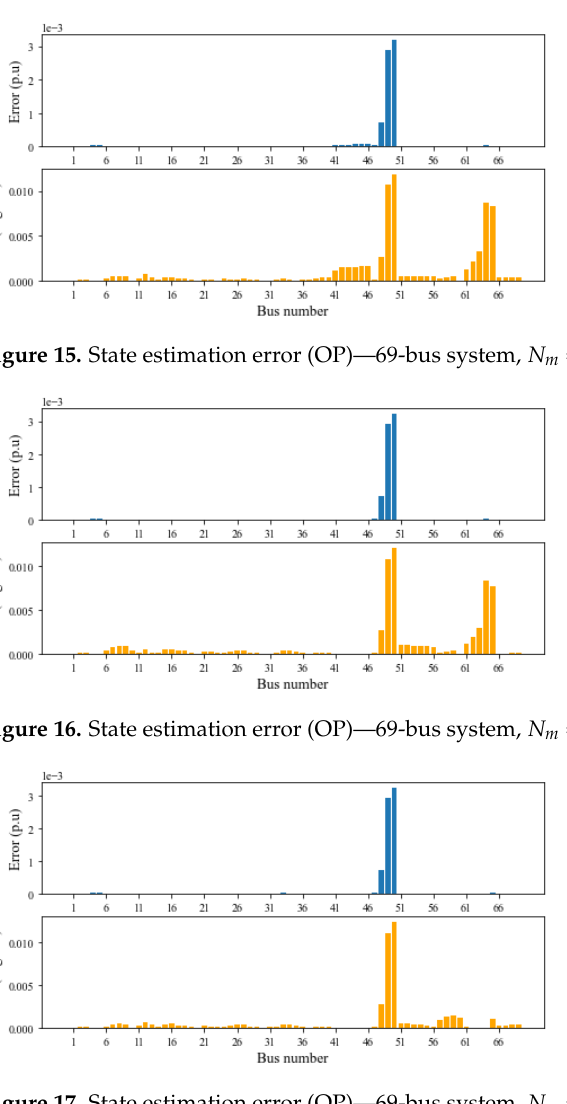
Figure 17. State estimation error (OP)—69-bus system, N m =